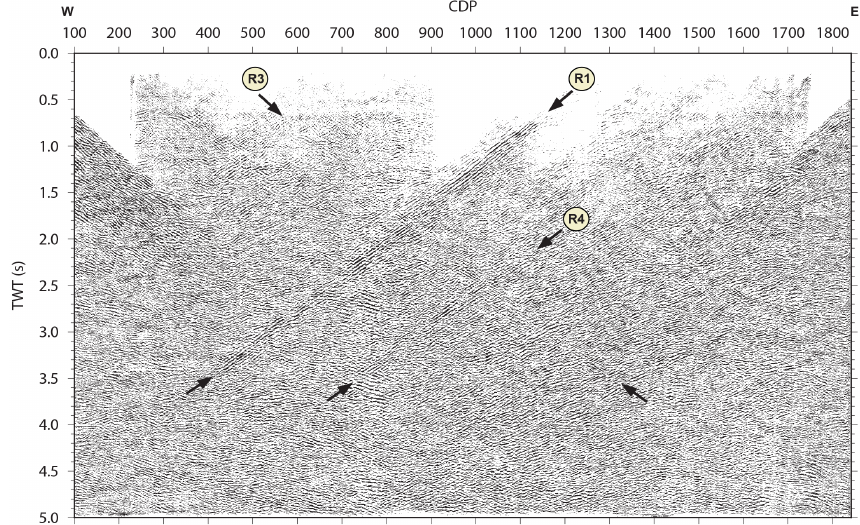
Figure 5. The NMO stacked section. Reflections R1 and R3 (shown by the arrows) correspond to the subsidiary west-dipping fault and the main Pärvie fault, respectively. Reflection R4 most likely is another west-dipping fault in the